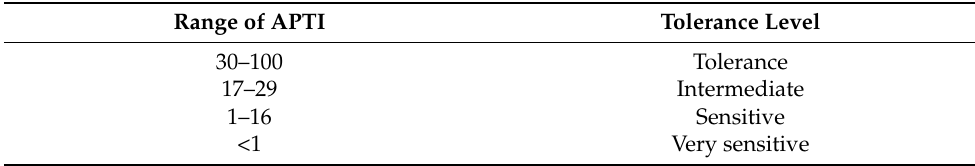
Table 1. The tolerance level of plants for